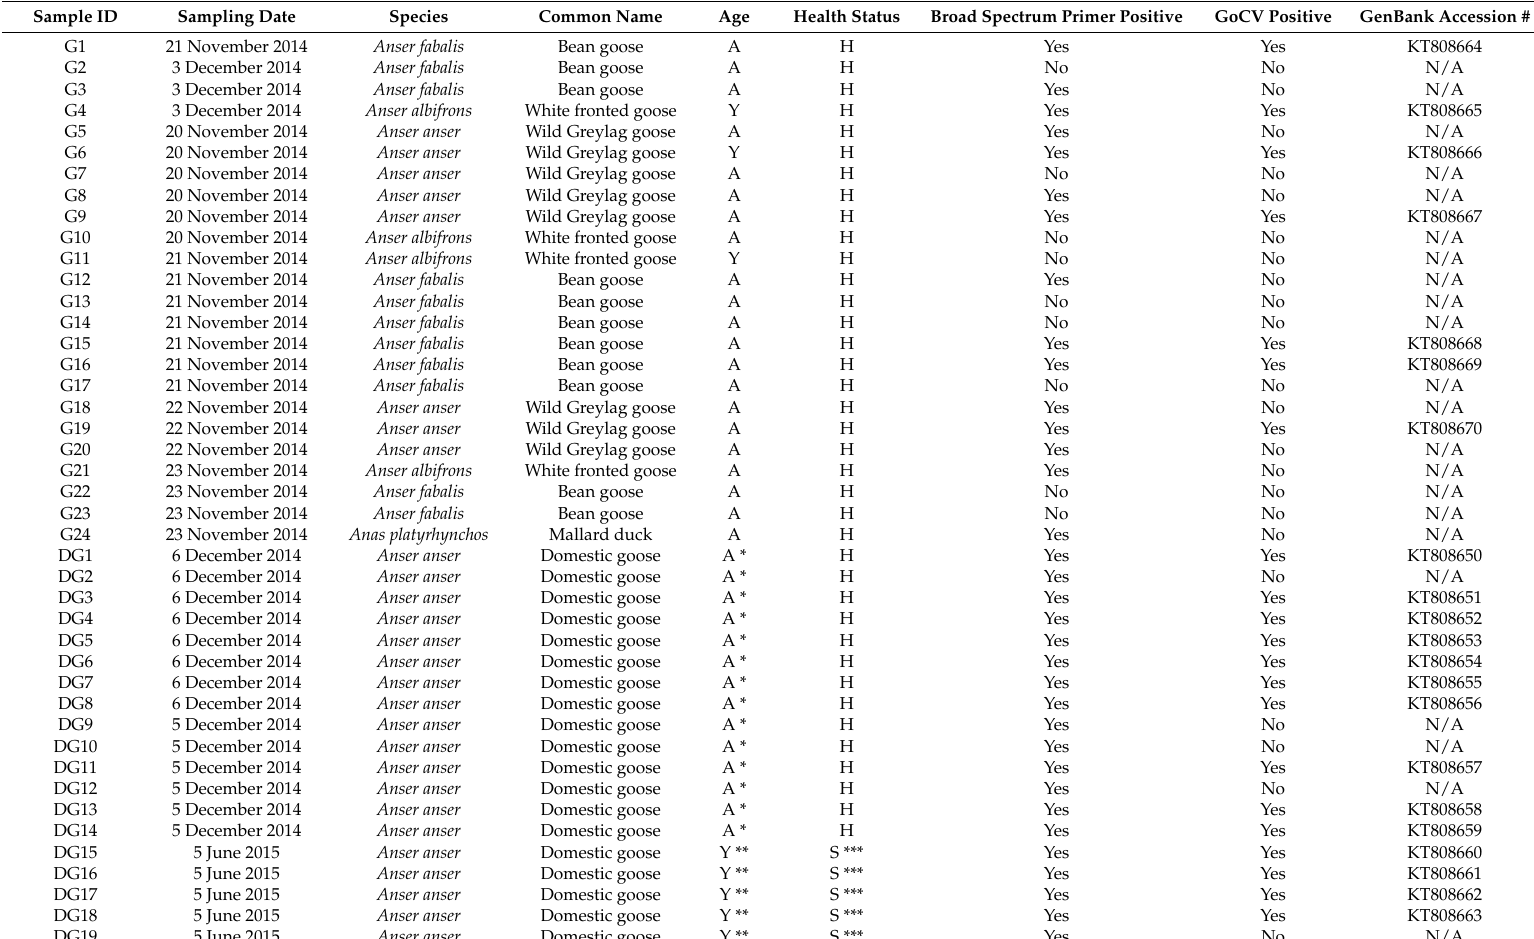
Table 1. Summary of all geese samples included in this study. Samples were prescreened by broad spectrum nested PCR by Halami , et al. [20]. Sample